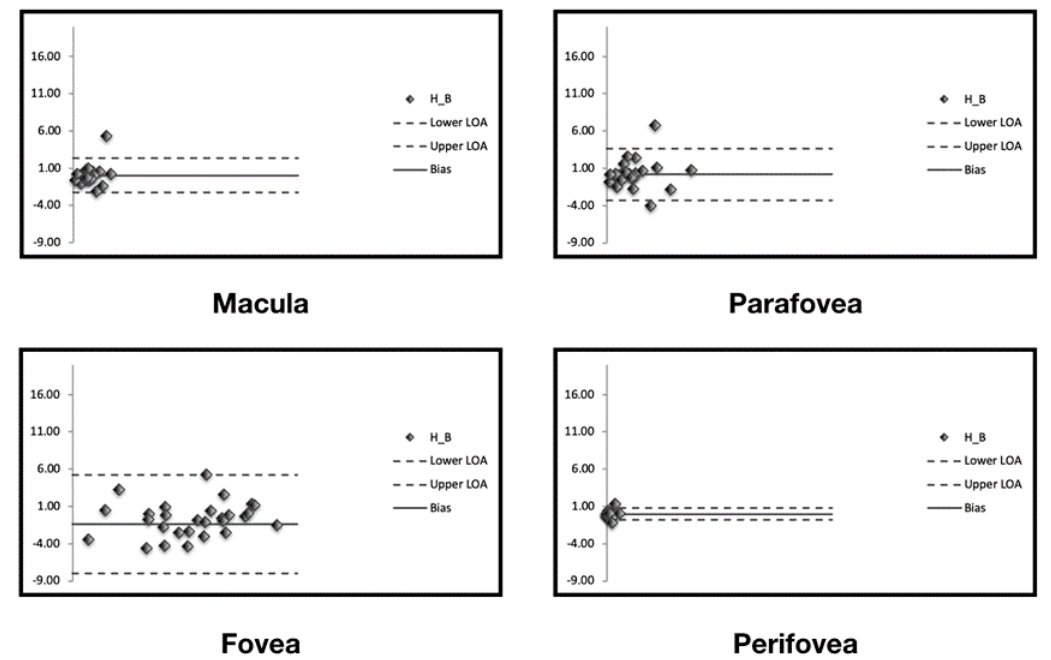
Figure 3. Bland–Altman graphs for repeatability agreement. The Bland–Altman graphs (one for each analyzed region) show the measurement differences for the area occupied by green-emitting fluorophores between two measurements (y-axis) vs. the mean of the two measurements (x-axis). The solid line indicates the mean difference and the dashed lines indicate the 95% limits of agreement. Table 1. Bland–Altman graphs for repeatability agreement. Macula Fovea Parafovea Perifovea Mean absolute intraobserver variability 0.0